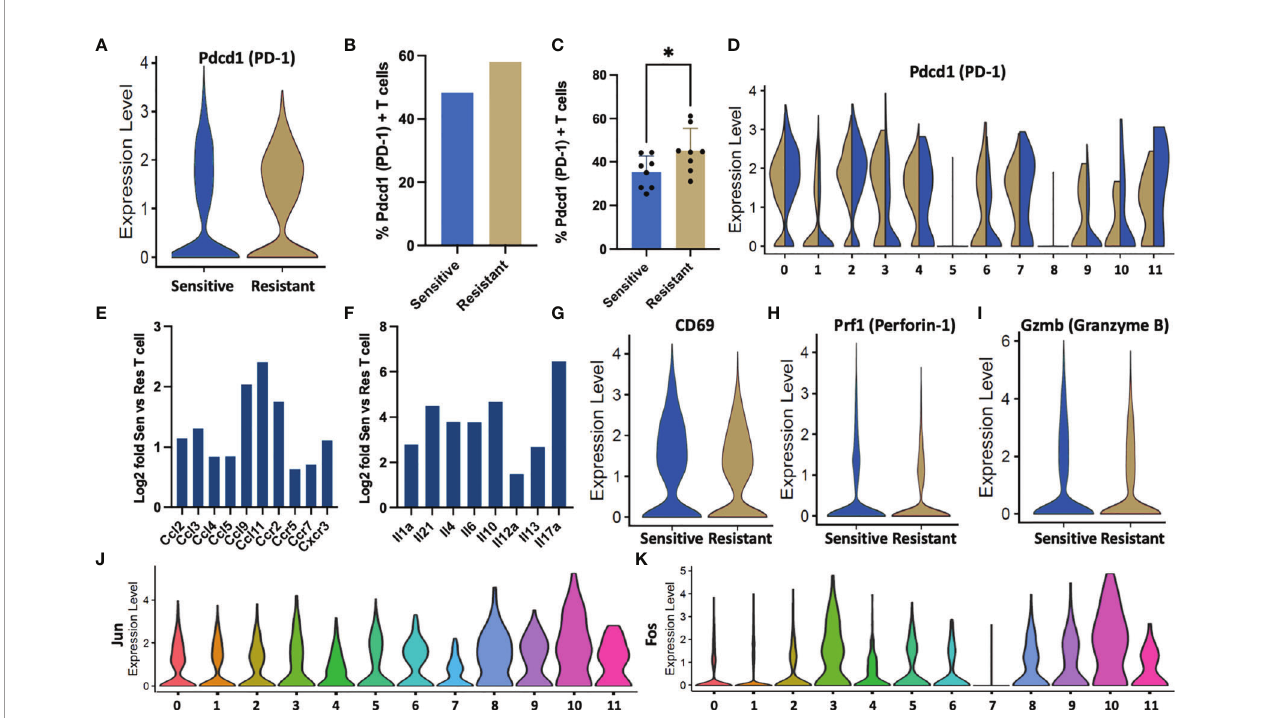
FIGURE 4 | T cell behavior in response to DOX sensitivity. (A) Violin plots denoting expression of Pdcd1 per T cell in sensitive or resistant tumors. (B) Percentage of tumor residing T cells expressing Pdcd1 as quanti fi ed in scRNA-Seq data. (C) PD-1+ T cells quanti fi ed from tumor in fi ltrated T cells following DOX treatment using fl ow cytometric analysis. (D) ScRNA-Seq expression levels of Pdcd1 by cluster ID depicted as violin plots. (E) Fold upregulation of chemokine and (F) cytokine genes in sensitive vs resistant T cell populations inferred from scRNA-Seq data. (G – I) Activation gene markers (CD69) and cytotoxic genes ( Prf1 , GzmB) associated with T cell activity expression in sensitive or resistant tumors depicted as violin plots. (J, K) Dimeric transcription factors comprising the AP-1 transcription factor indicative of T cell activation expression segregated by cell types identi fi ed in single cell transcriptomic data. * p ≤